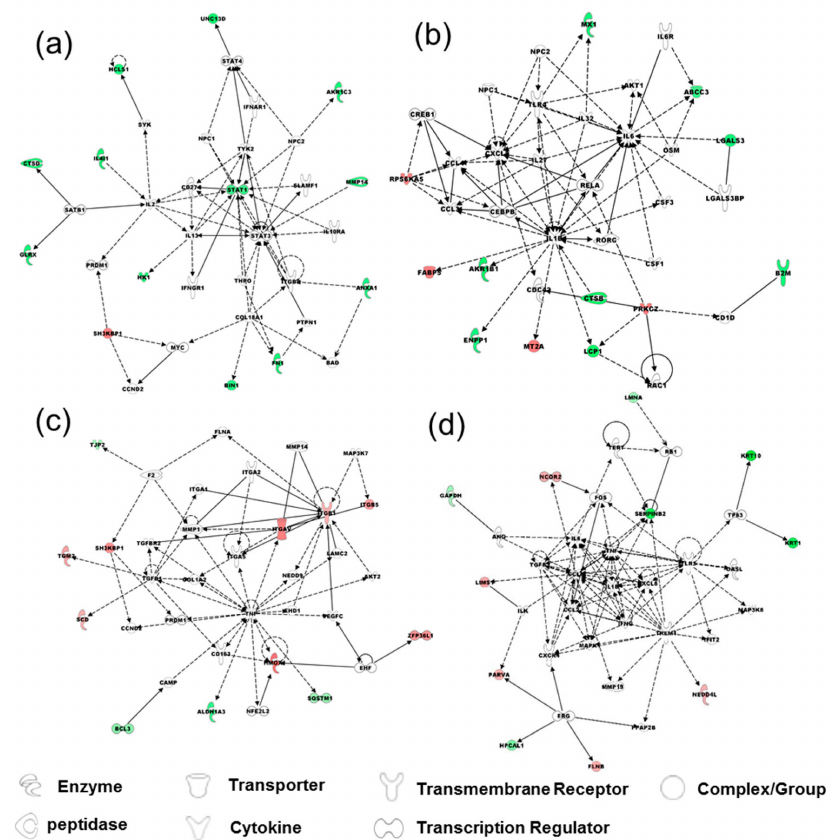
Figure 4. Functional network analysis of differentially regulated proteins with z-score cutoff 95% observed in EMT of HCV29 and KK47 cells, using Ingenuity Pathways Analysis (IPA). Top network functions of ( a ) cellular development, cellular growth and proliferation, hematological system development and function; ( b ) cell death and survival, cell morphology, cellular development in TGF- β -induced EMT of HCV29. Top network functions of ( c ) cancer, cellular movement, tumor morphology; ( d ) cell-to-cell signaling and interaction, tissue development, cell death and survival. Solid lines: direct known interactions. Dashed lines: suspected or indirect interactions. White: proteins known to be in the network but not identified in our study. Red: proteins upregulated in the EMT process. Green: proteins downregulated in the EMT